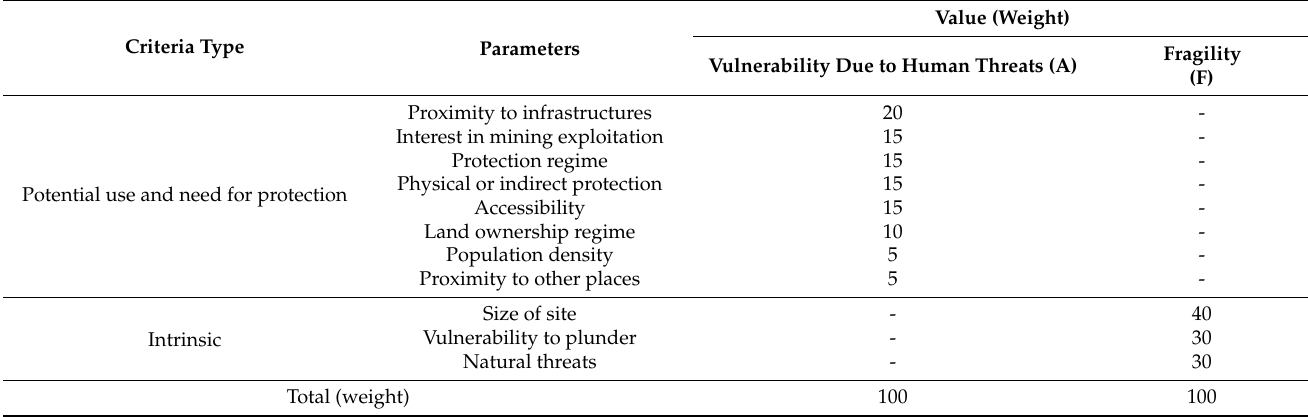
Table 3. Weighting is based on assessing fragility and vulnerability due to anthropic threats. Interpretation of DS: maximum (400), very high (400–200), high (199–68), medium (67–13), and low (<13) [17].